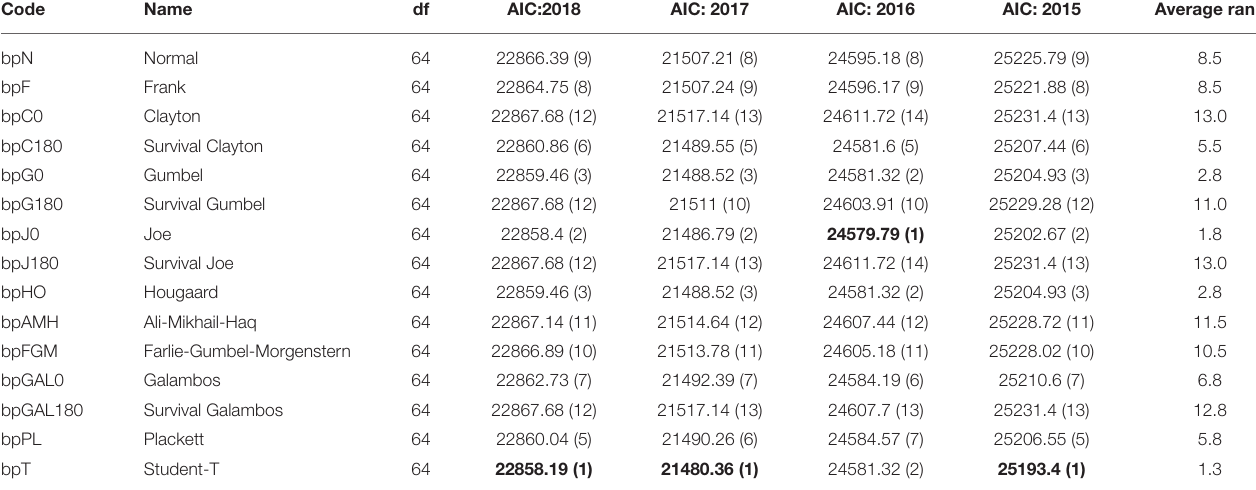
TABLE 2 | Ranking of bivariate error models based on AIC.